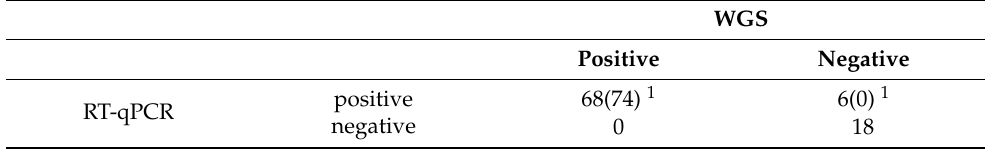
Table 2. Comparison of genotypic carbapenemase detection in Enterobacterales by WGS and